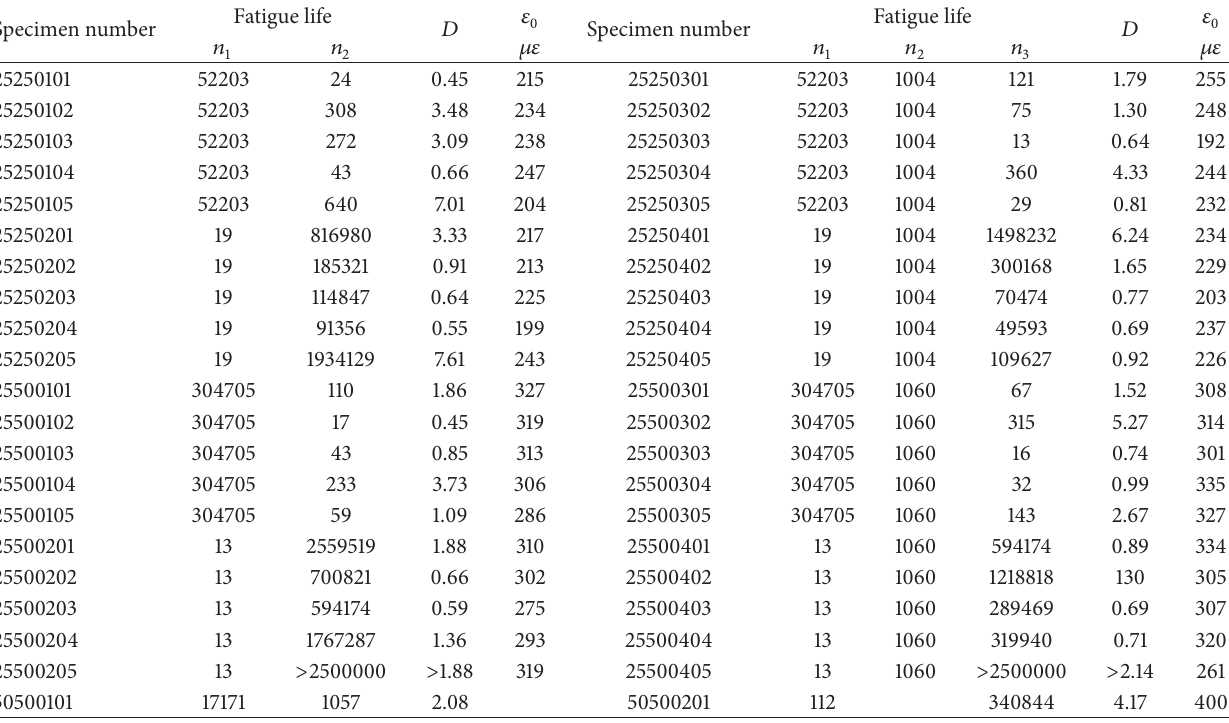
Table 2: Test data of fatigue for variable amplitude.